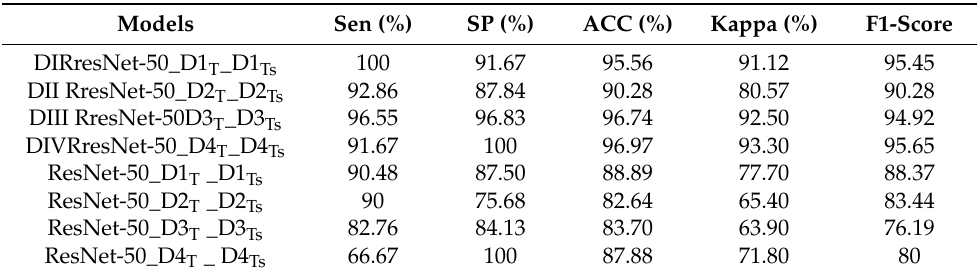
Table 8. The comparison between density-specific models ResNet-50; D*RresNet-50_D* Ts means the ResNet-50 model adapted for density type “*”, fine-tuned with the training CBIS-DDSM dataset D* T and was tested on test dataset D* TS .